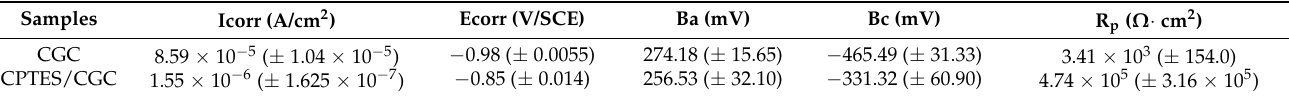
Table 4. Corrosion potentials, corrosion current densities, Tafel constants and polarization resistance values obtained via the Tafel fit of the polarization scan.